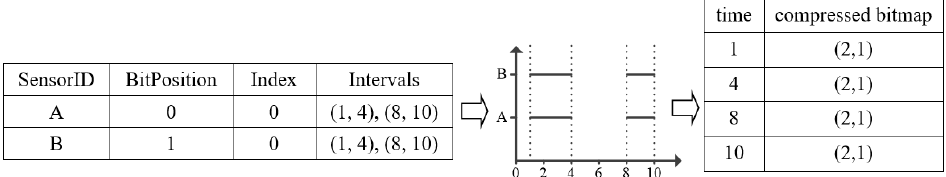
Figure 5. Interval Deletion Example.